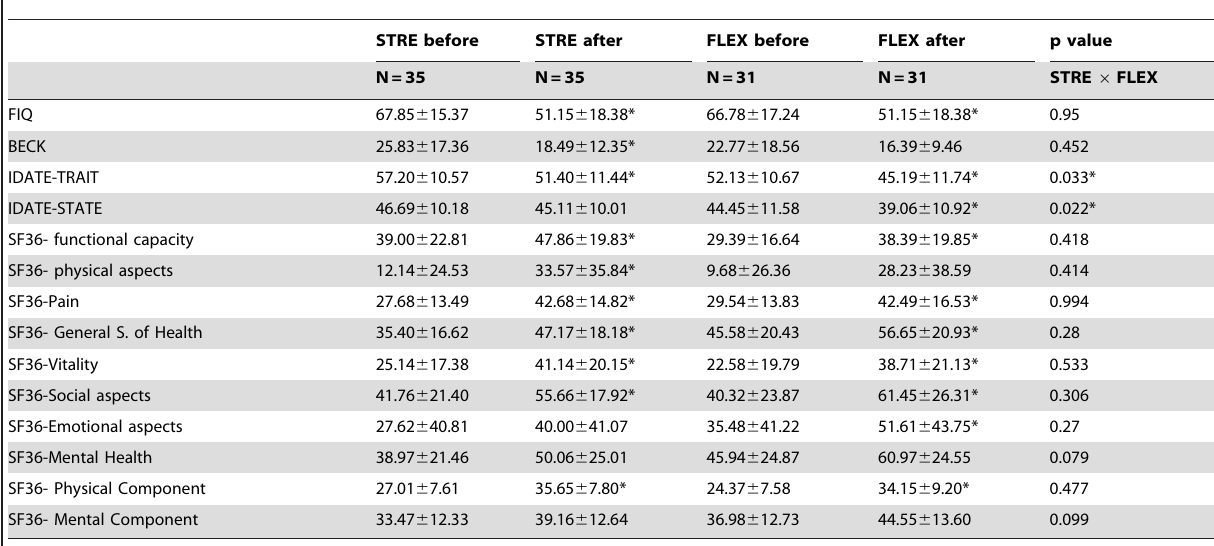
Table 3. Effects of exercise on function, symptoms, life quality, anxiety and depression.